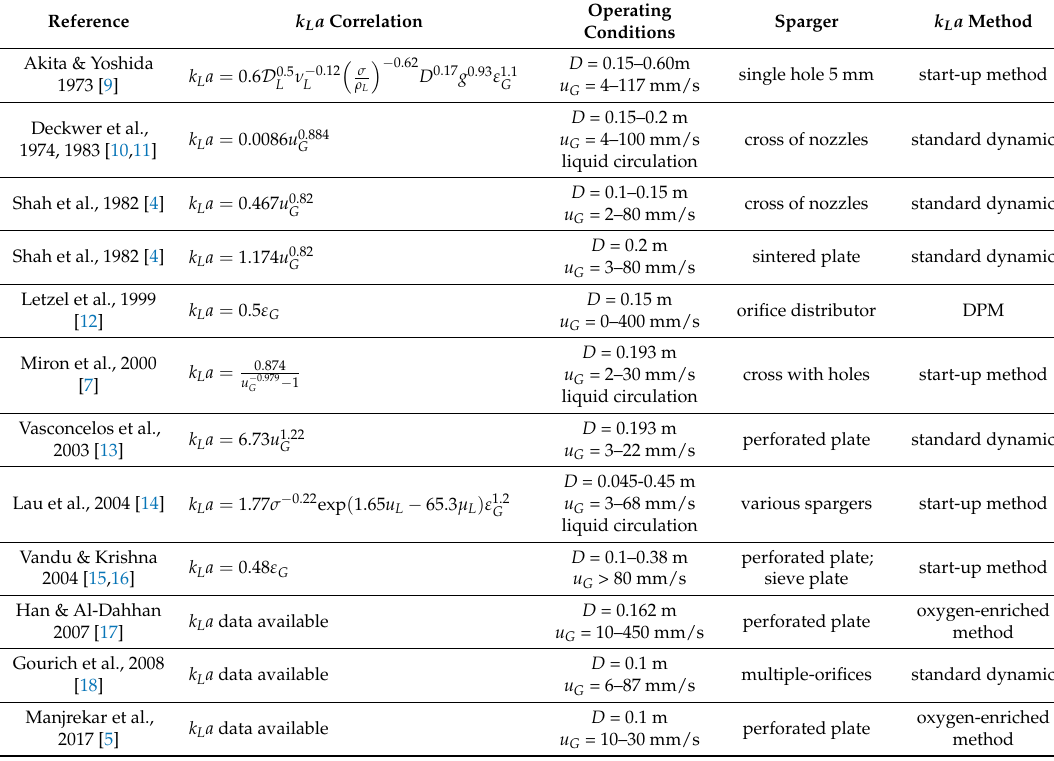
Table 1. Available data and correlations for prediction of volumetric mass transfer coefficient in coalescent batch (distilled water, tap water, ambient pressure and